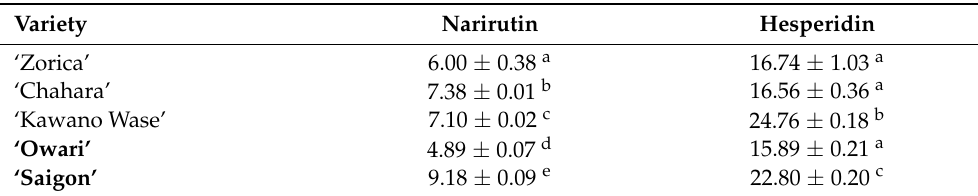
Table 5. Flavonoid content in the dry mandarin pulp residue. Results are expressed per g of dry weight mandarin pulp (mg/g DW).